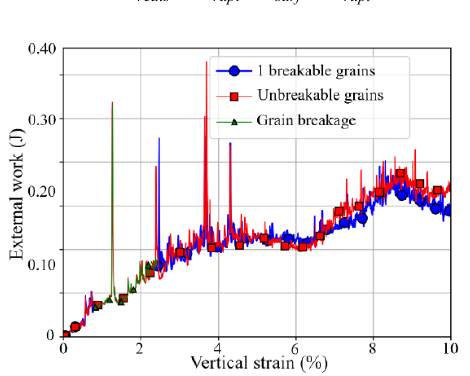
Fig. 6 . Example of an oedometric compression of a single breakable grain among a set of non-breakable grains: evolution of external